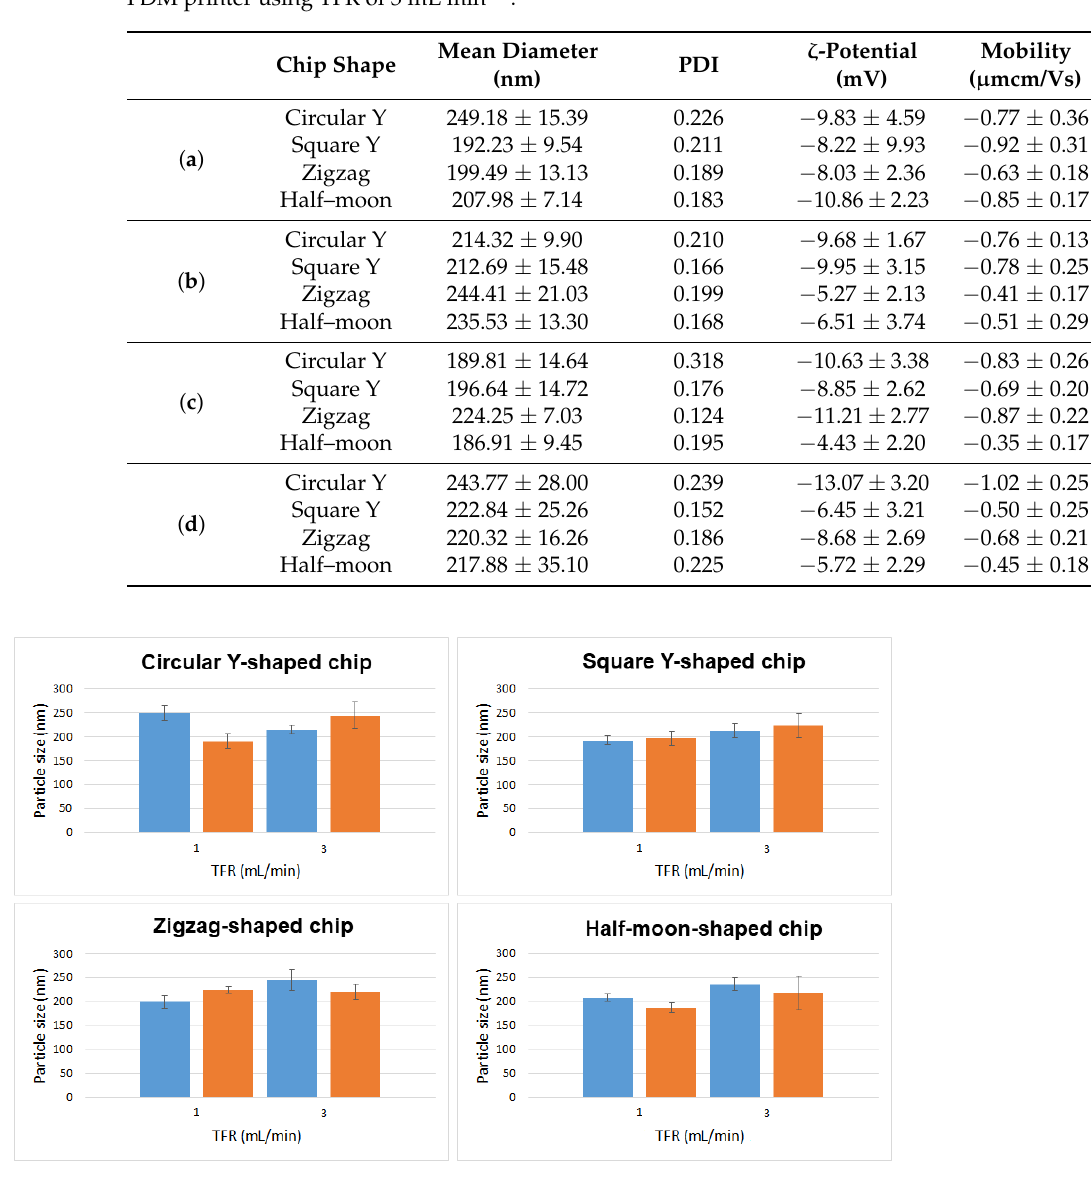
Table 2. Mean particle size, polydispersity index (PDI), ζ -potential, and mobility of curcumin-loaded liposomes prepared using circular Y-shaped, square Y-shaped, zigzag-shaped, and half-moon-shaped chips ( a ) fabricated by LCD printer us- ing TFR of 1 mL min −1 , ( b ) fabricated by LCD printer using TFR of 3 mL min −1 , ( c ) fabricated by FDM printer using TFR of